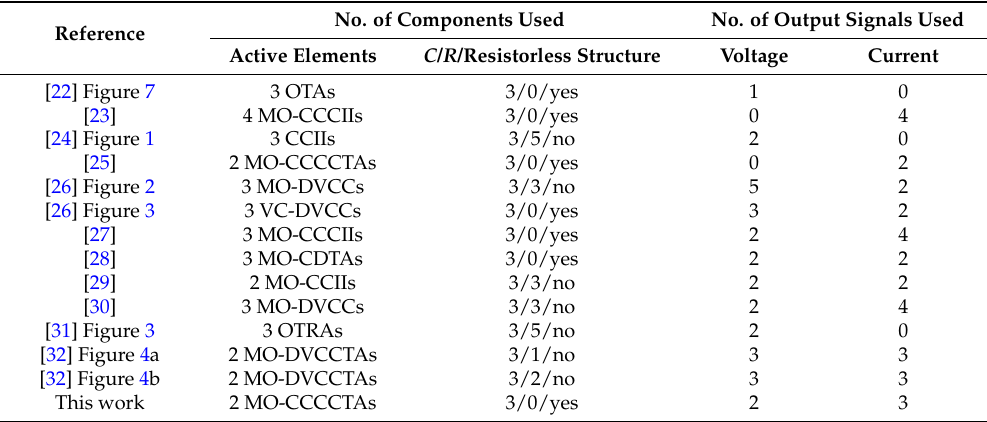
Number of component and number of output signal comparisons with previous third-order oscillators.